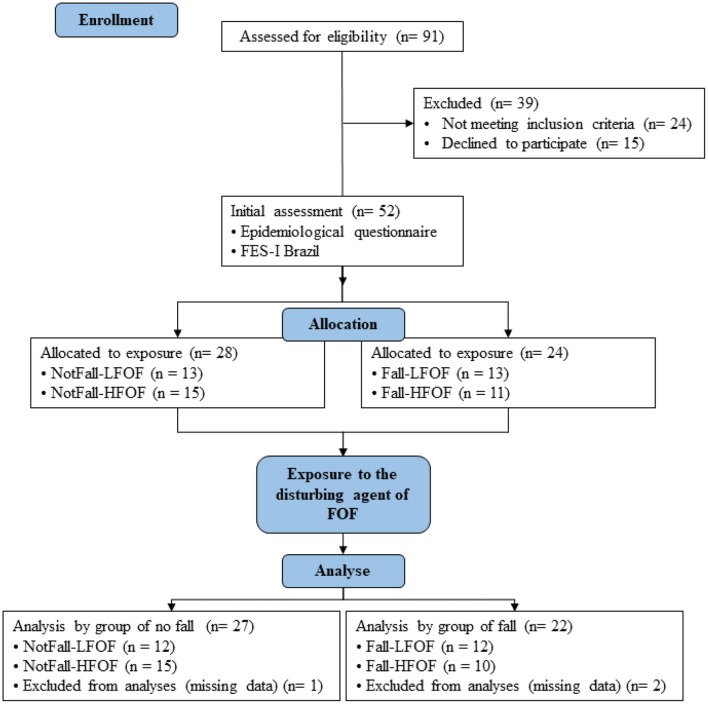
Study flowchart.